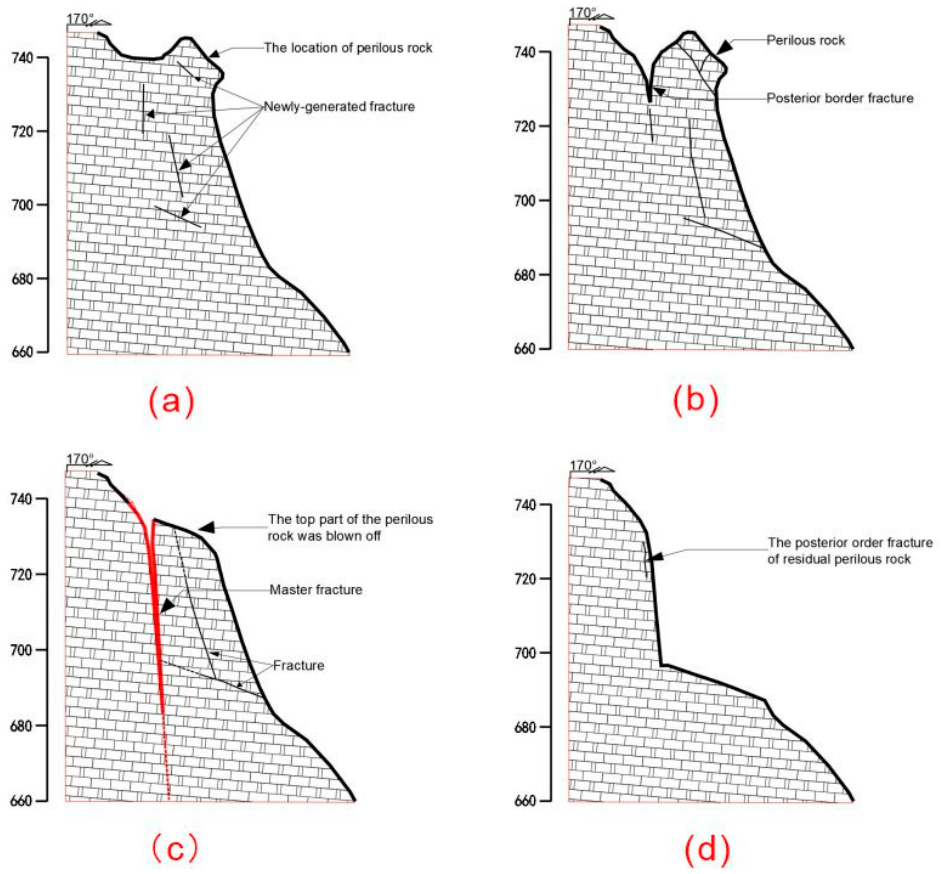
Figure 10. Evolution process of Yizhuxiang collapse; ( a ) Fracture formation stage; ( b ) Rear edge fracture formation stage; ( c ) Collapse formation stage; ( d ) Fracture penetration stage.